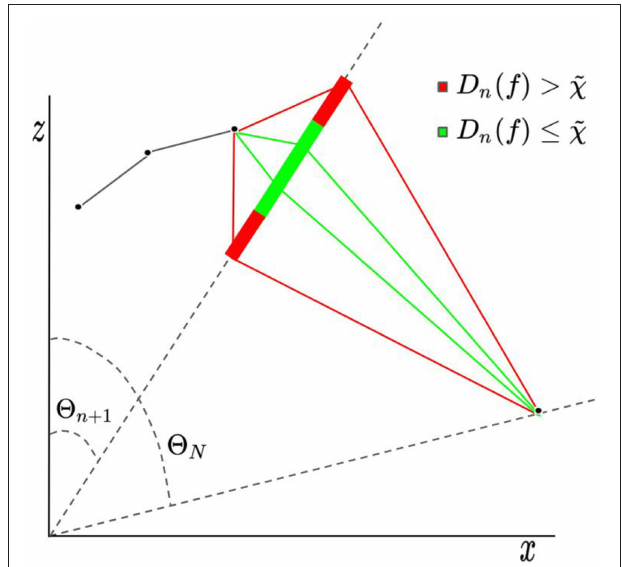
FIGURE 5 | This diagram illustrates how f is defined piece-wise in terms of the functions f 1 , f 2 , and f 3 . In the top image, the three functions are shown as a graph of r vs. θ . In the bottom image, it is shown how the functions correspond to three different parts of the field-line.